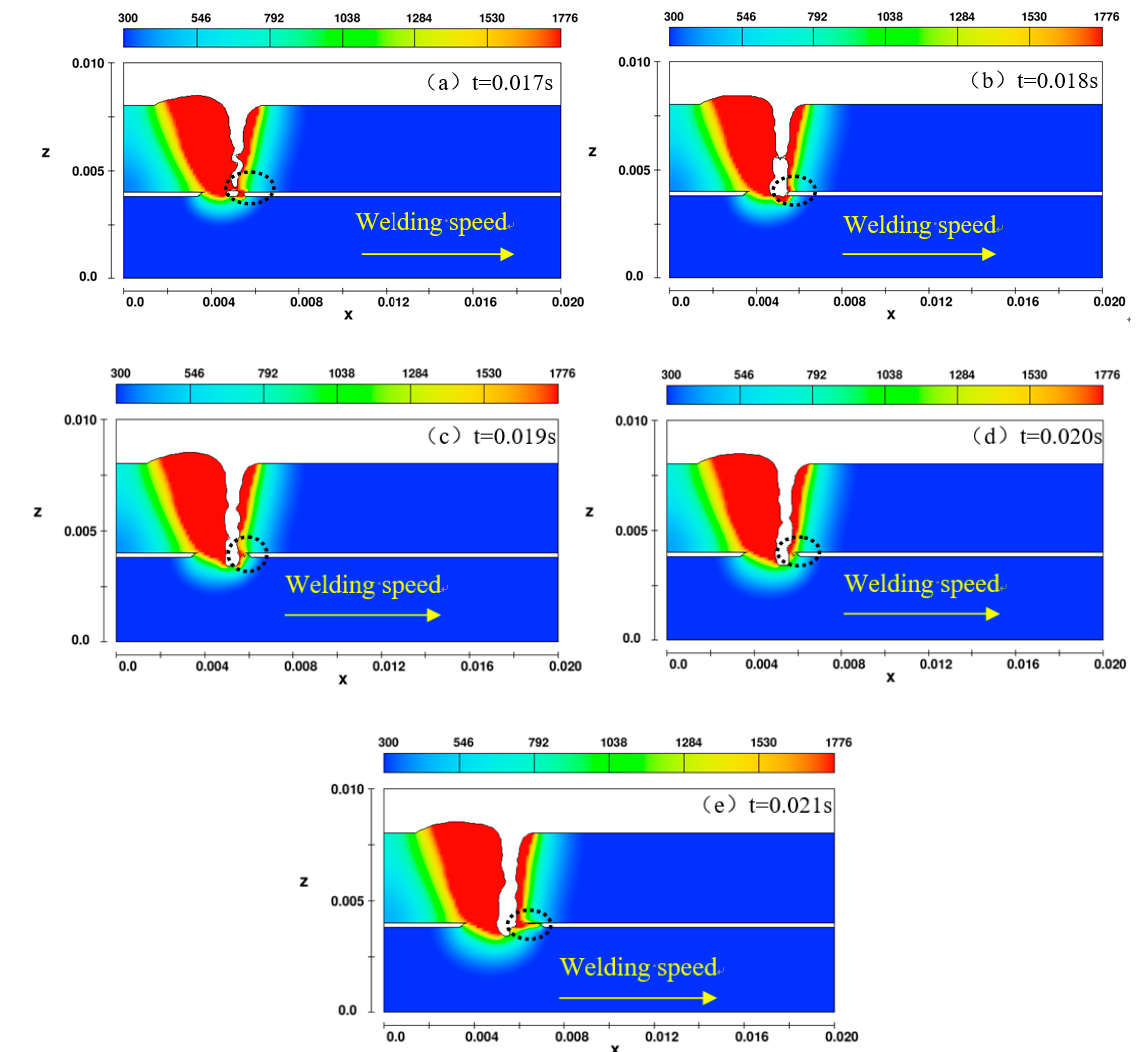
Figure 4. The pool connecting mechanism in the gap location along the x-z plane.